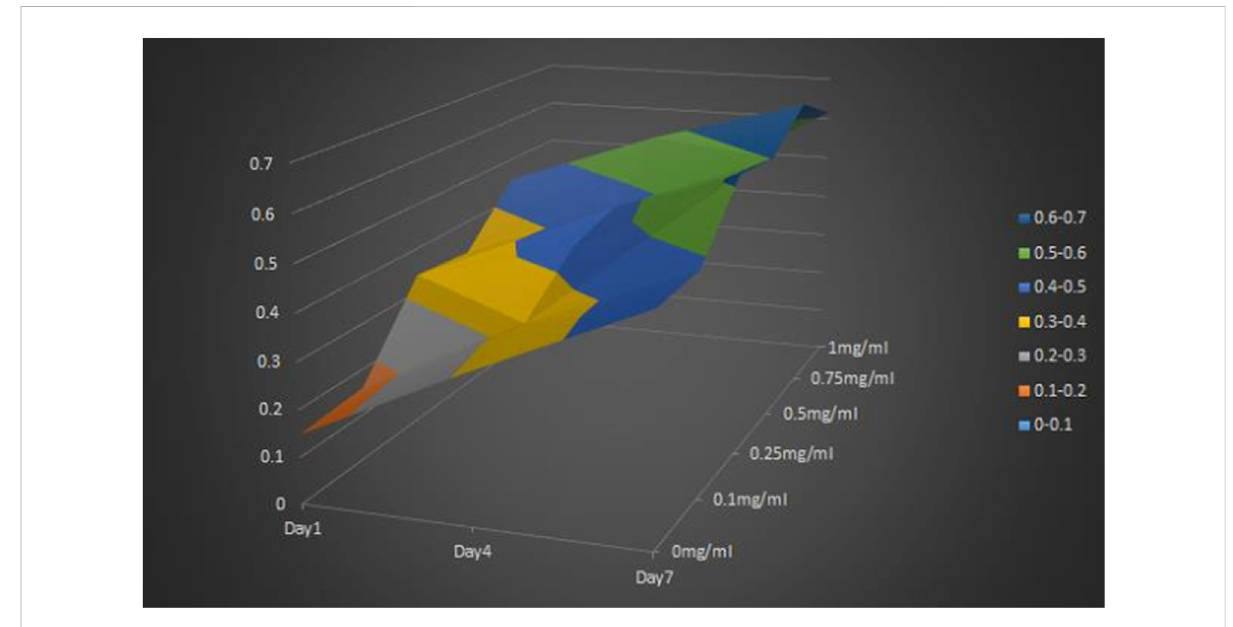
FIGURE 1 MTT method for screening the optimal concentration of the cross-linking compound of HLC-I and